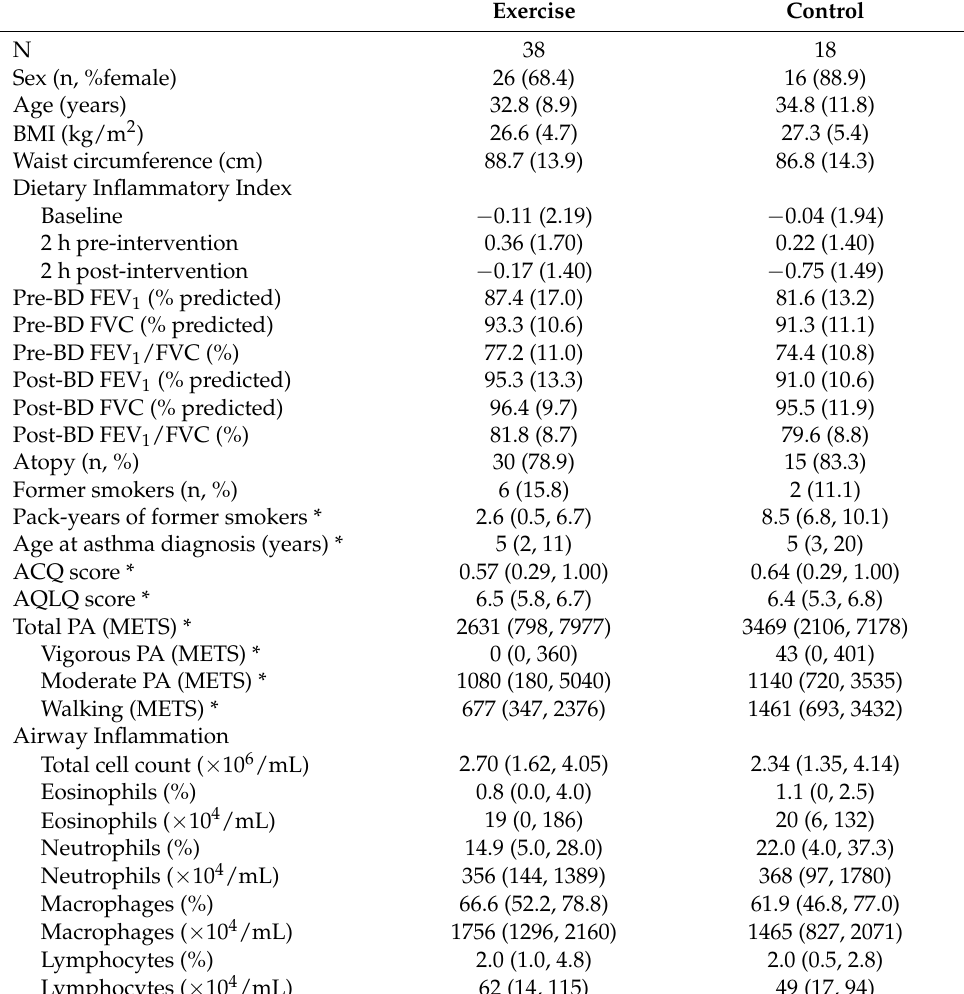
Figure 1. Flowchart of study participants. Table 1. Participant